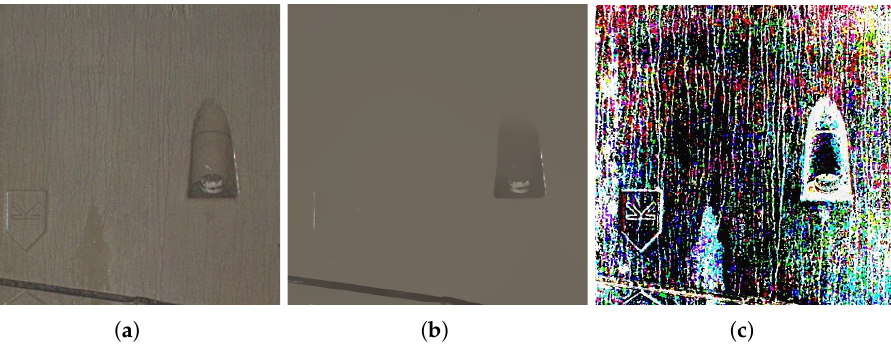
Figure 4. Original and residual images. ( a ) Original image; ( b ) Base layer extracted by L 0 norm; ( c ) Residual